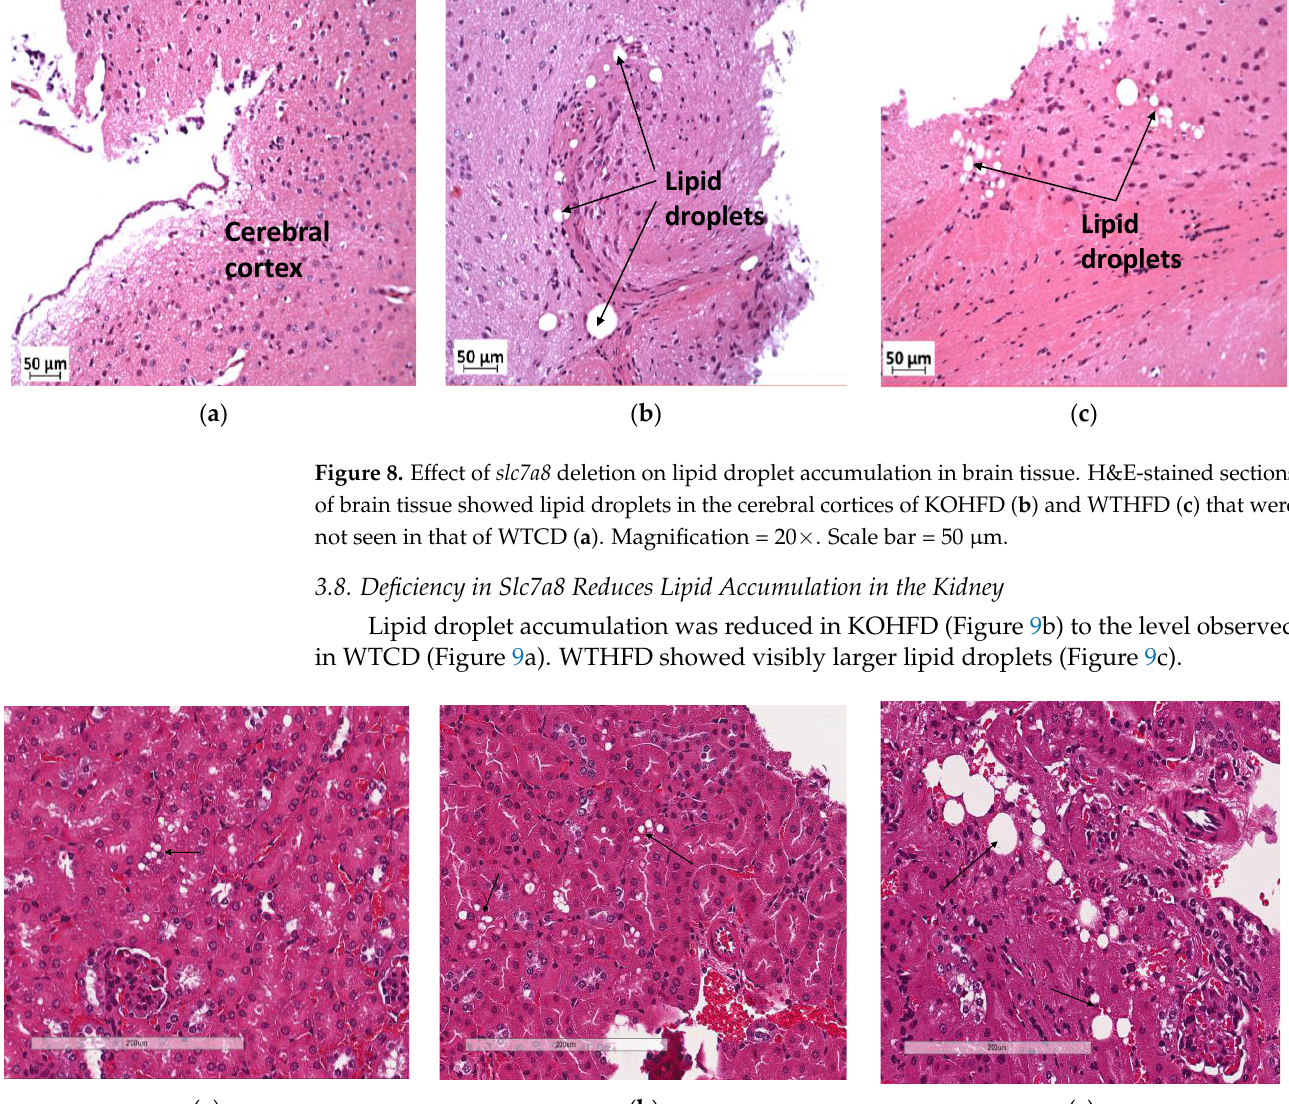
Figure 7. Effect of slc7a8 on epicardial adipose tissue accumulation in the heart. H&E-stained heart sections showed a greater accumulation of epicardial adipose tissue, seen as a brown/beige adipose depot, in the WTHFD ( c ) compared to WTCD ( a ) and KOHFD ( b ). The images demonstrate that the WTHFD ( f ) mice had more connective tissue (cardiac muscle fibres) than WTCD ( d ) and KOHFD ( e ). Magnification = 20×. Scale bar = 200 µm.